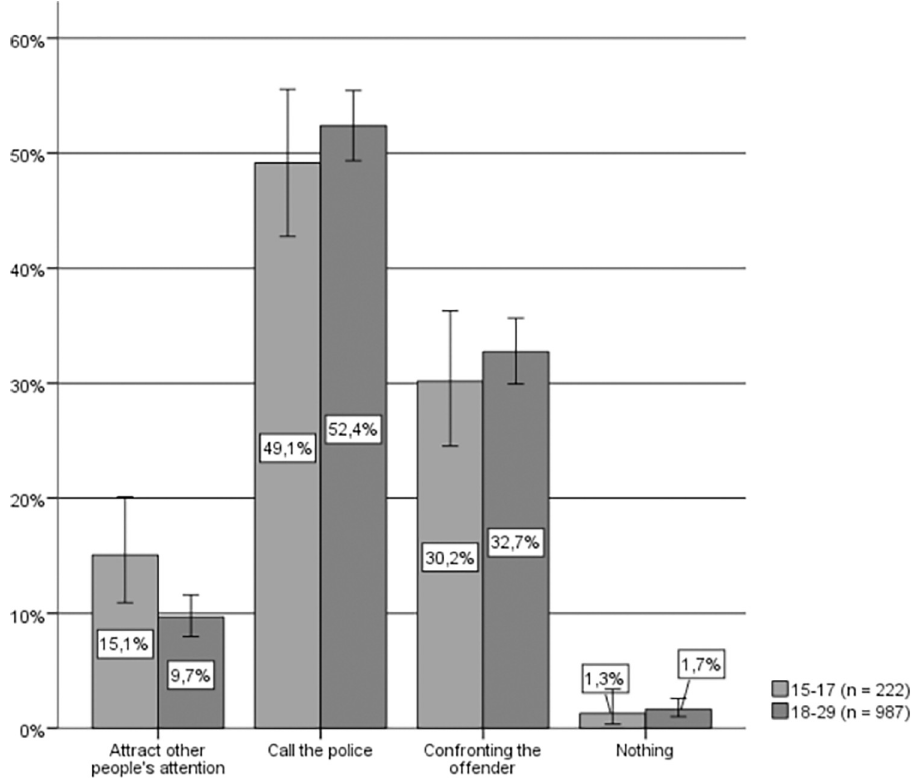
Fig 8. Hypothetical response to IPVAW, young men by age group. Source: Own elaboration based on CIS study 2992 [49], question 14. 95% confidence intervals are provided for each subsample.